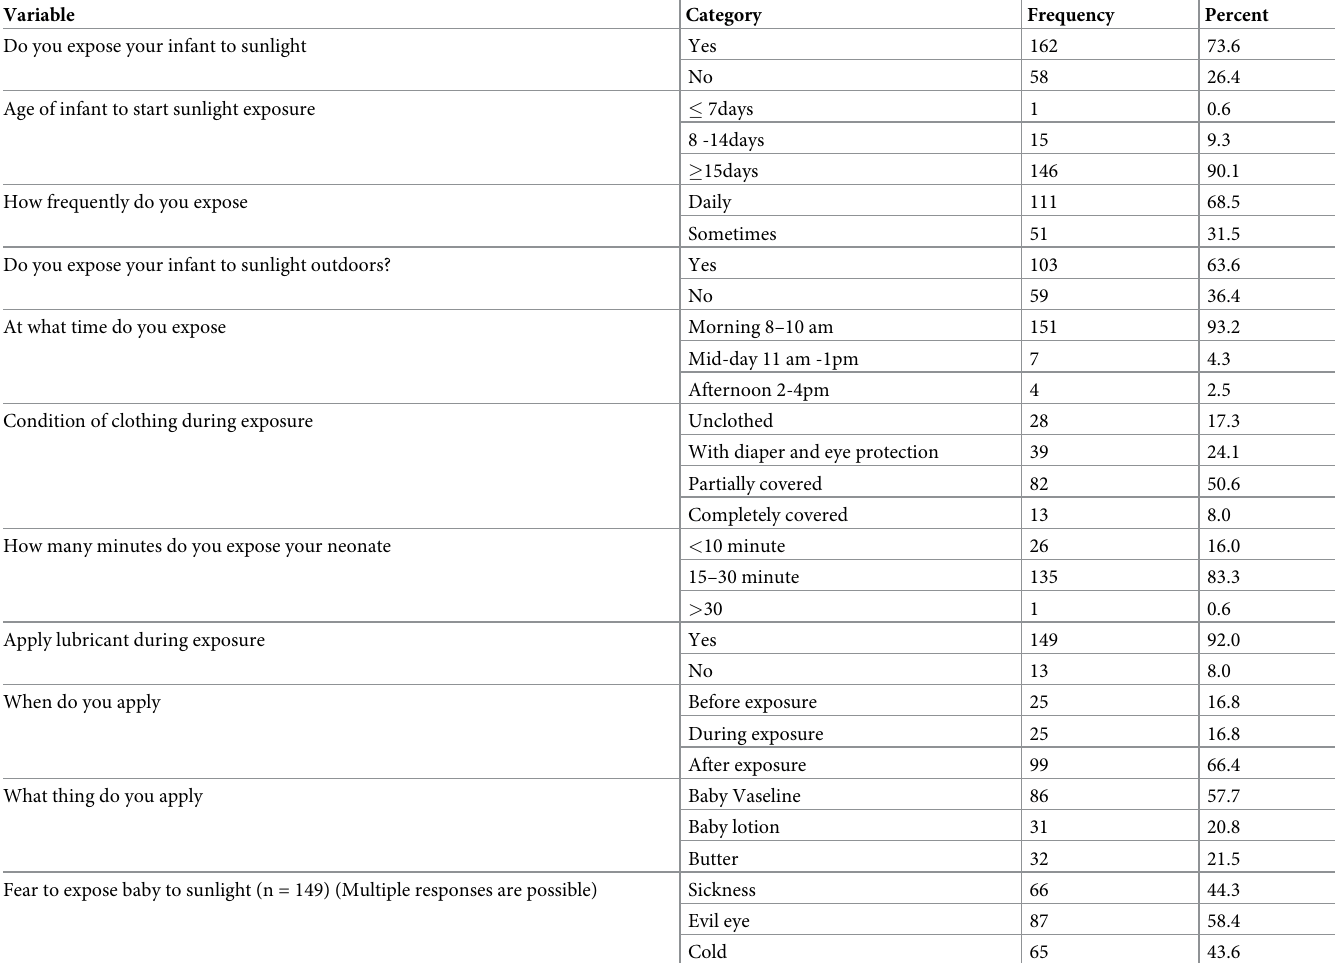
Table 4. Practice infants’ sunlight exposure among mothers attending the EPI unit at WUSH,